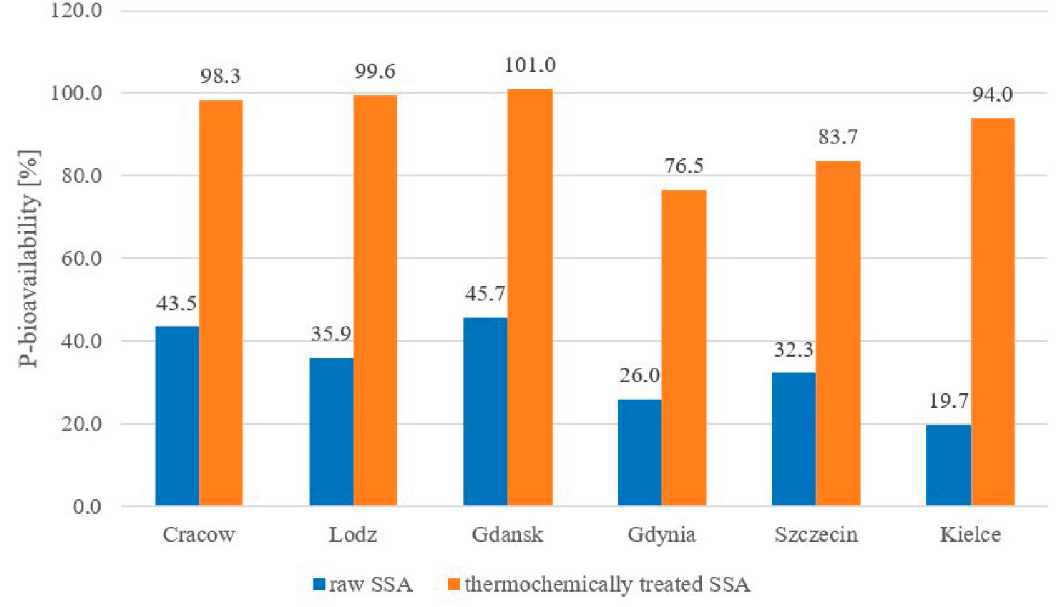
Figure 2. Phosphorus bioavailability (stated as solubility in neutral ammonium citrate P NAC ) of the SSA generated in selected Polish mono-incineration plants—before and after thermochemical treatment.